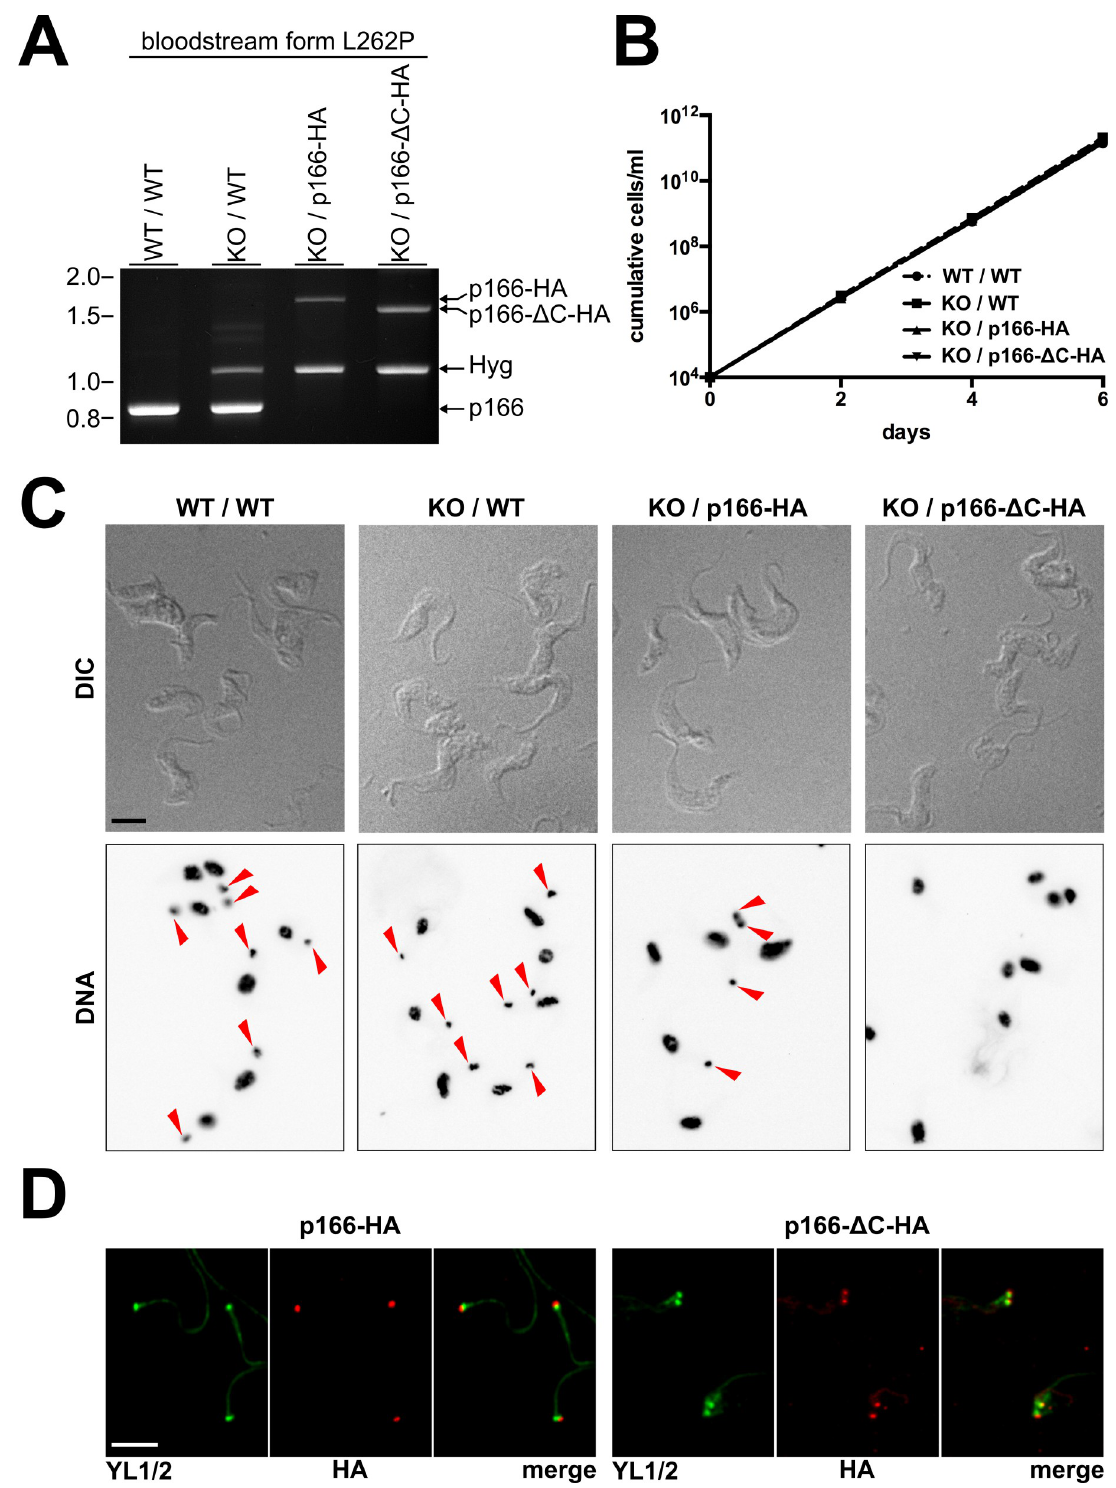
Fig 6. C-terminal truncated p166 localizes correctly in the L262P bloodstream form cell line. (A) Ethidiumbromide stained agarose gel after gelelectrophoresis of specific PCR products to analyze the p166 alleles of the indicated L262P bloodstream form cell line variants. Sizes of DNA molecular weight marker bands in kb are indicated on the left. (B) Growth curve analysis of cell lines harbouring indicated alleles. (C) Fluorescence microscopic analysis of the indicated L262P bloodstream form cell lines. Whole cells are visualized using